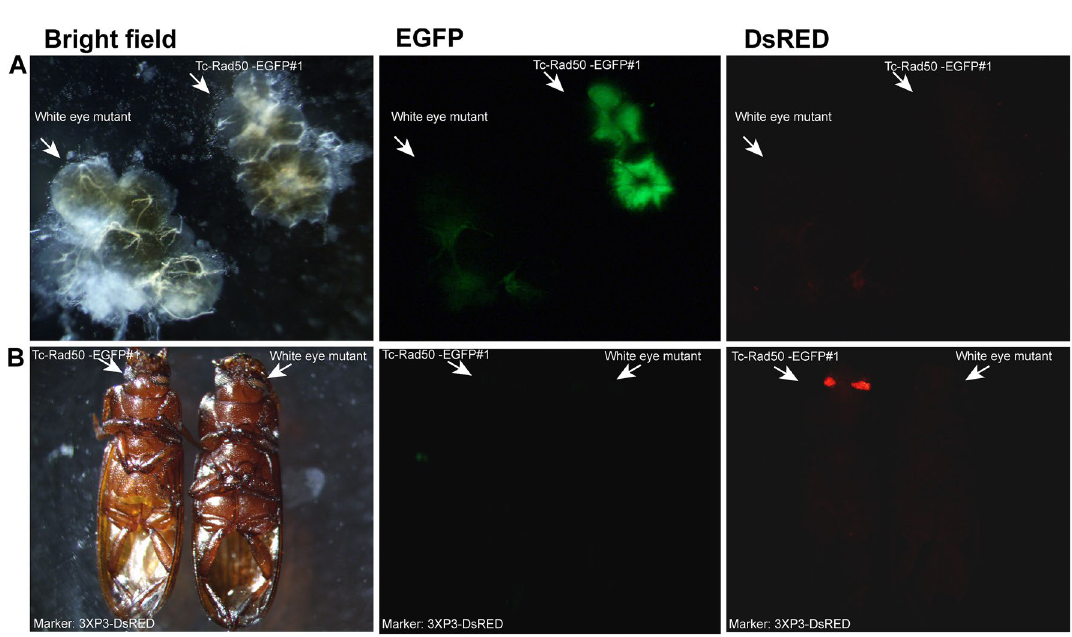
Figure 5. Tc - rad50 regulatory regions drive EGFP expression in testes. ( A ) Testes from transgenic beetles (upper right) and non-transgenic beetles (lower left) viewed under bright field, EGFP or DsRED filters. ( B ) Adult transgenic (left) and non-transgenic (right) viewed under bright field, EGFP or DsRED filters. Arrows indicate the eyes and testes where DsRED and EGFP expression, respectively, were expected for transgenic Tc-Rad50-EGFP#1 line